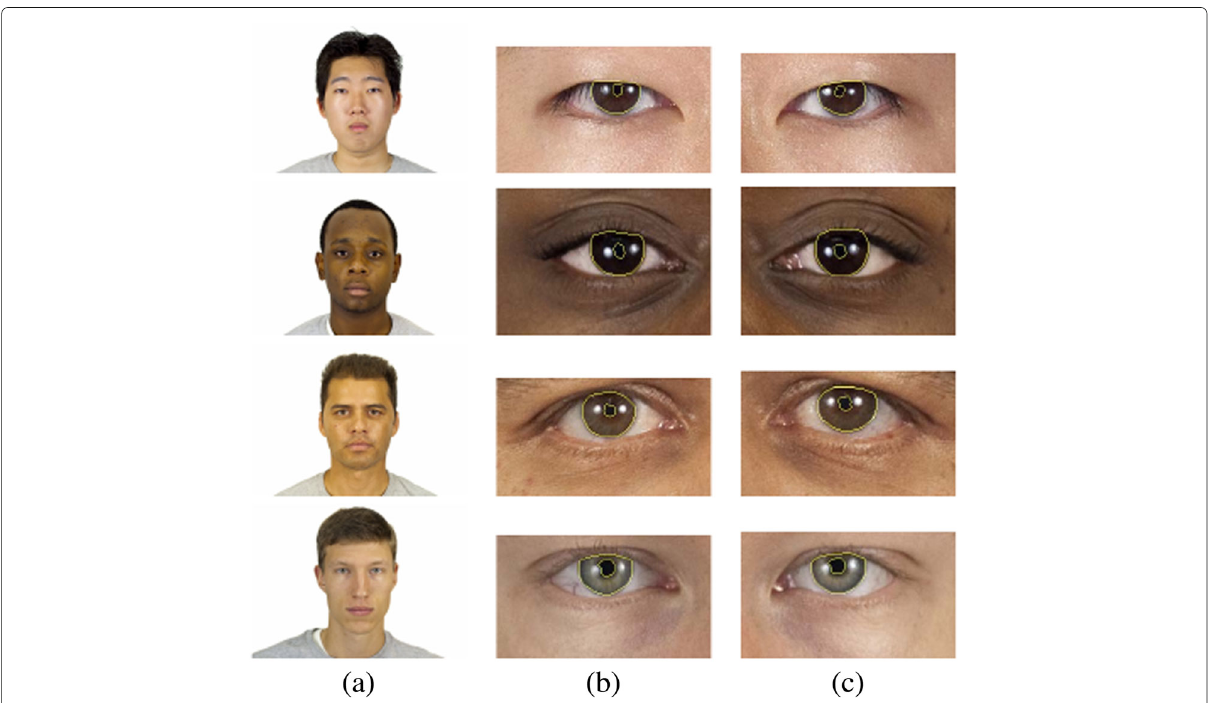
Fig. 8 Some examples of correct iris segmentation. Rows: Asian, Black, Latino and White ethnicity, respectively. Original face ( a ), right iris segmentation ( b ) and left iris segmentation ( c